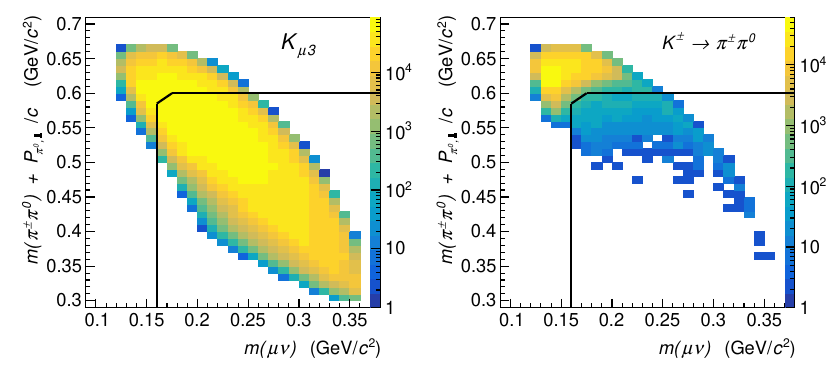
Figure 5. Distributions of the kinematic variables used for K ± MC simulated signal K ± (left) and background K ± µ 3 indicated by solid